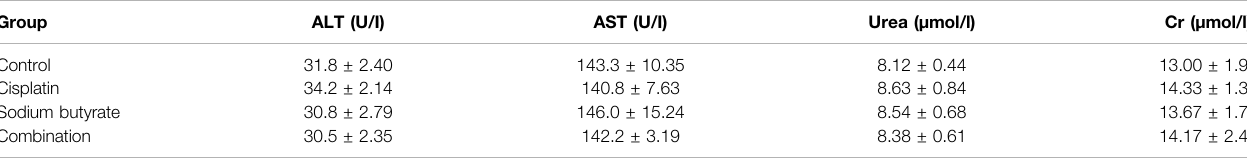
TABLE 2 | Effect of sodium butyrate combined with cisplatin or alone on hepatic and renal function.